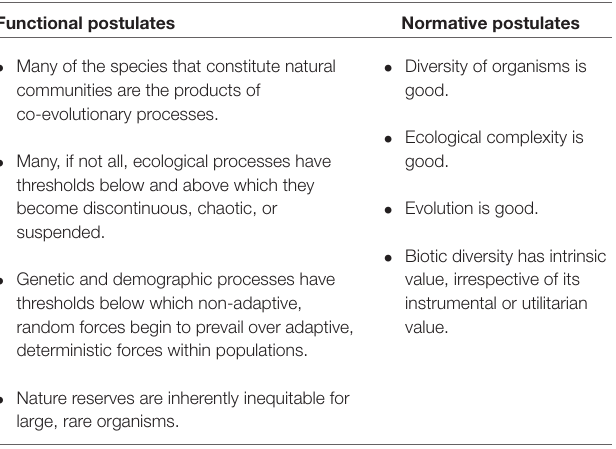
TABLE 1 | Summary of Soule’s (1985) functional and normative postulates for the field of conservation biology. Functional postulates Normative postulates